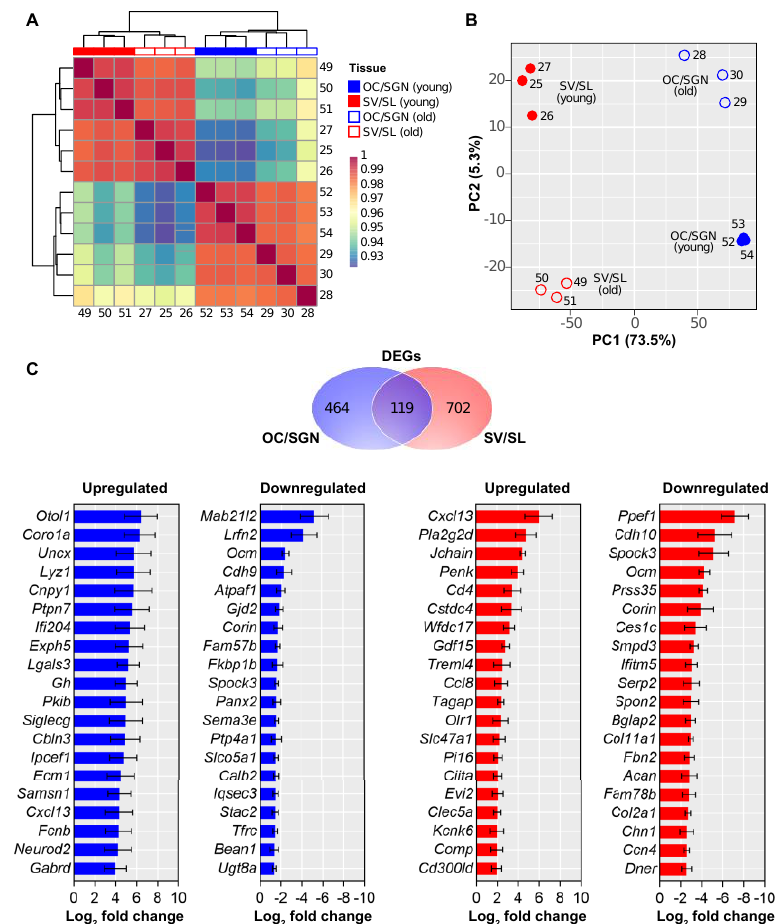
Figure 2. Cochlear substructures show distinct age-related changes in gene expression ( A ) Hier- archical clustering heatmap of Pearson correlation coefficients reveals clustering between cochlear substructure replicates. The legend indicates replicate identities. ( B ) Principal component analysis re- veals clustering of replicates by substructure. The largest variance (PC1 or 73.5%) separates replicates by substructure (OC/SGN versus SV/SL), whereas separation by age (young versus old) accounts for a much smaller fraction of the variance (PC2 or 5.3%). Replicate identities are indicated. ( C ) A Venn diagram of genes differentially expressed with ageing (DEGs) shows that there are both unique and overlapping DEGs between the OC/SGN (blue) and the SV/SL (red). The 20 genes most up- and downregulated with ageing in each substructure are shown. The complete list of DEGs is available in Supplemental Table